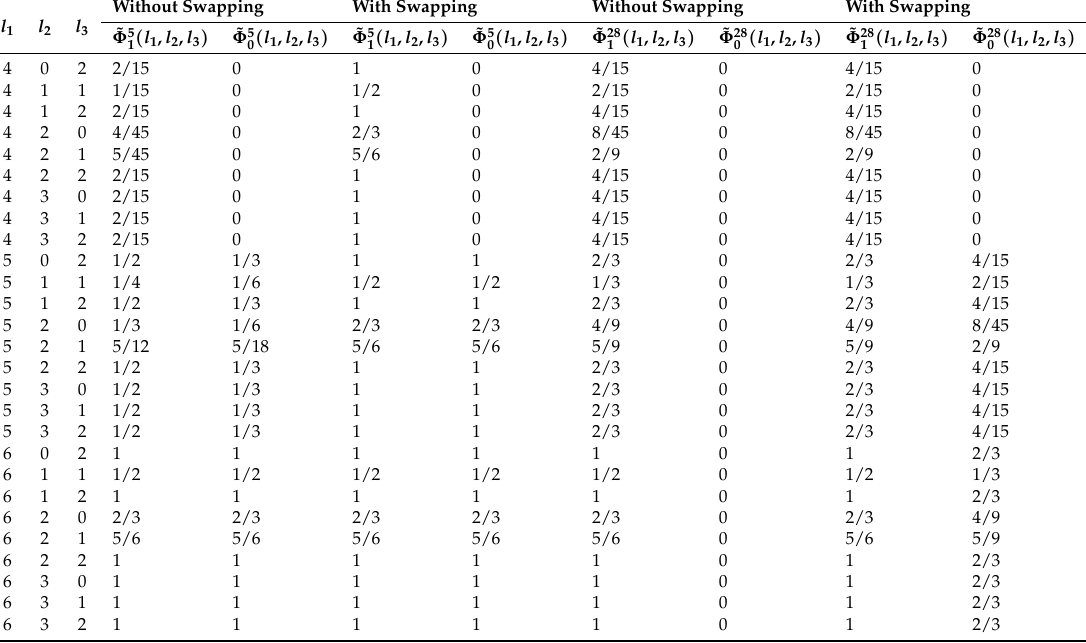
Table A1. ˜ Φ 1 and ˜ Φ 0 for components 5 and 28 without and with swapping (rows with ˜ Φ ( l 1 , l 2 , l 3 ) = 0 are